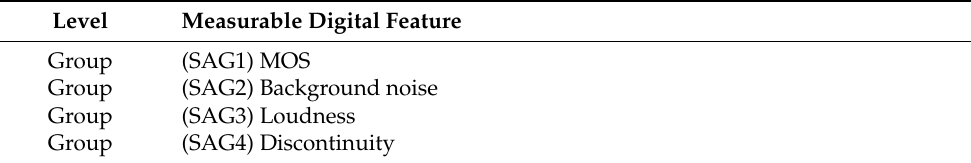
Table 14. Set of digital features defined for “sound analysis” category, corresponding to features E11, E12, E13 and E14.